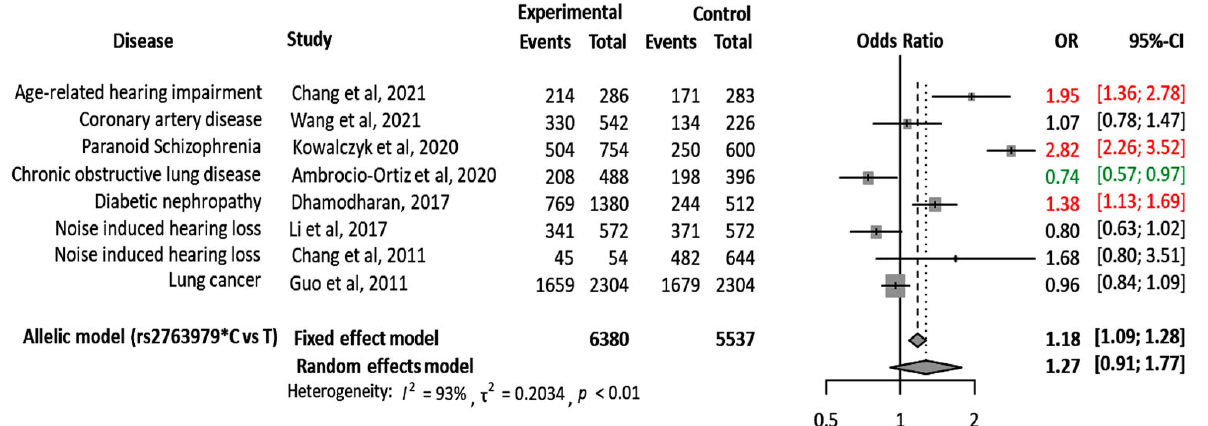
Figure 3. Forest plot of the pooled data for the association between HSPA1B rs2763979 variant and different disorders under the allelic model stratified by the type of the disorder [14,16,17,41,43,46–48]. Red text indicates significant increased risk of association, while green text indicates significant protective association with the disease, OR: odds ratio, CI: confidence interval. The meta ‐ analysis was carried out using the Comprehensive Meta ‐ analysis package version 3.0 (Biostat, Englewood, NJ, USA).